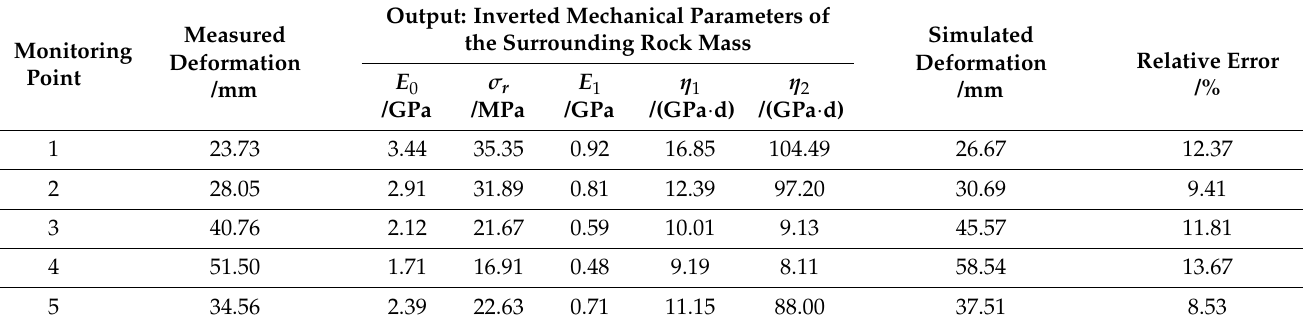
Table 9. Parameter inversion of surrounding rock mass and error